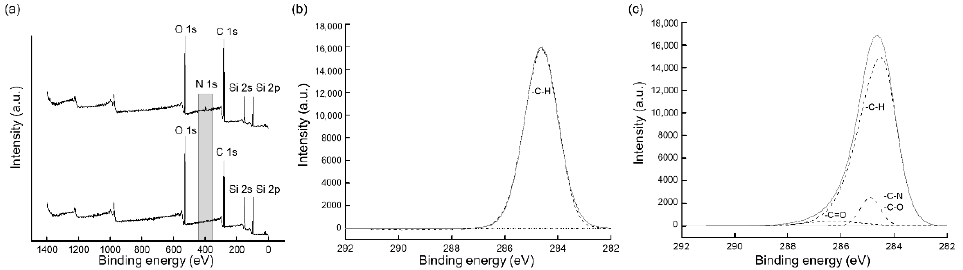
Figure 4. XPS analyses performed on bare and PDA-coated PDMS surfaces. ( a ) Survey spectrum, ( b ) high-resolution spectrum of bare PDMS − C1s, and ( c ) high-resolution spectrum of PDA-coated PDMS − C1s.